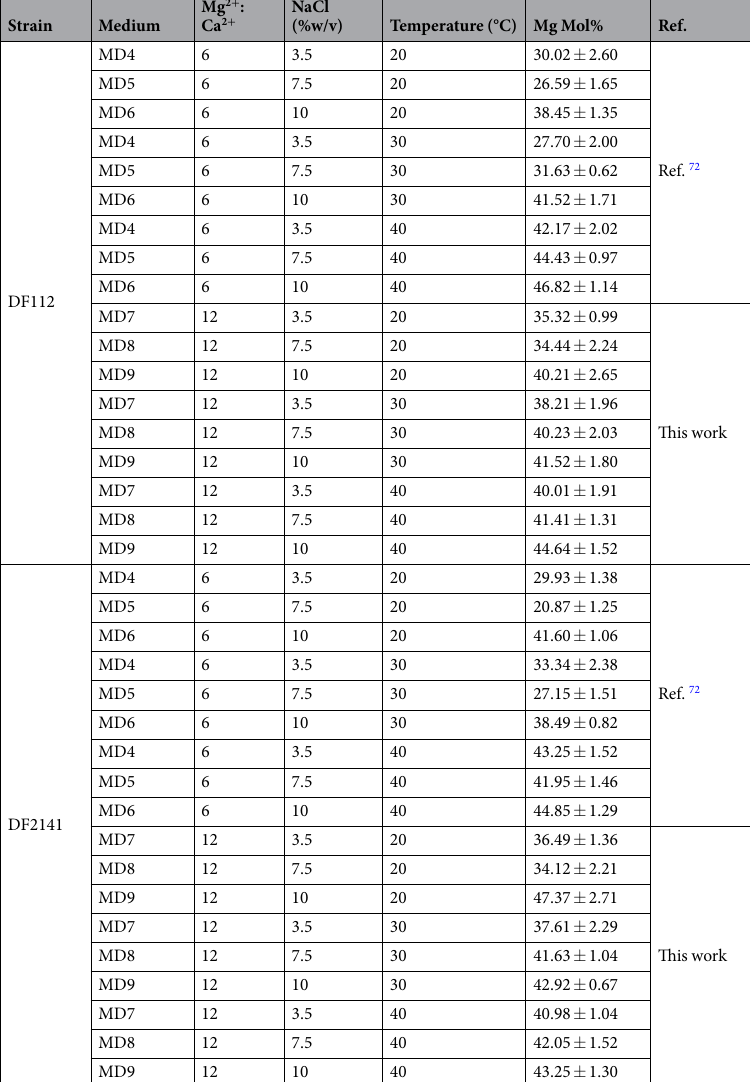
Table 2. Mg Mol% of the crystals recovered from different cultures. Adapted from corresponding PhD Dissertation 71